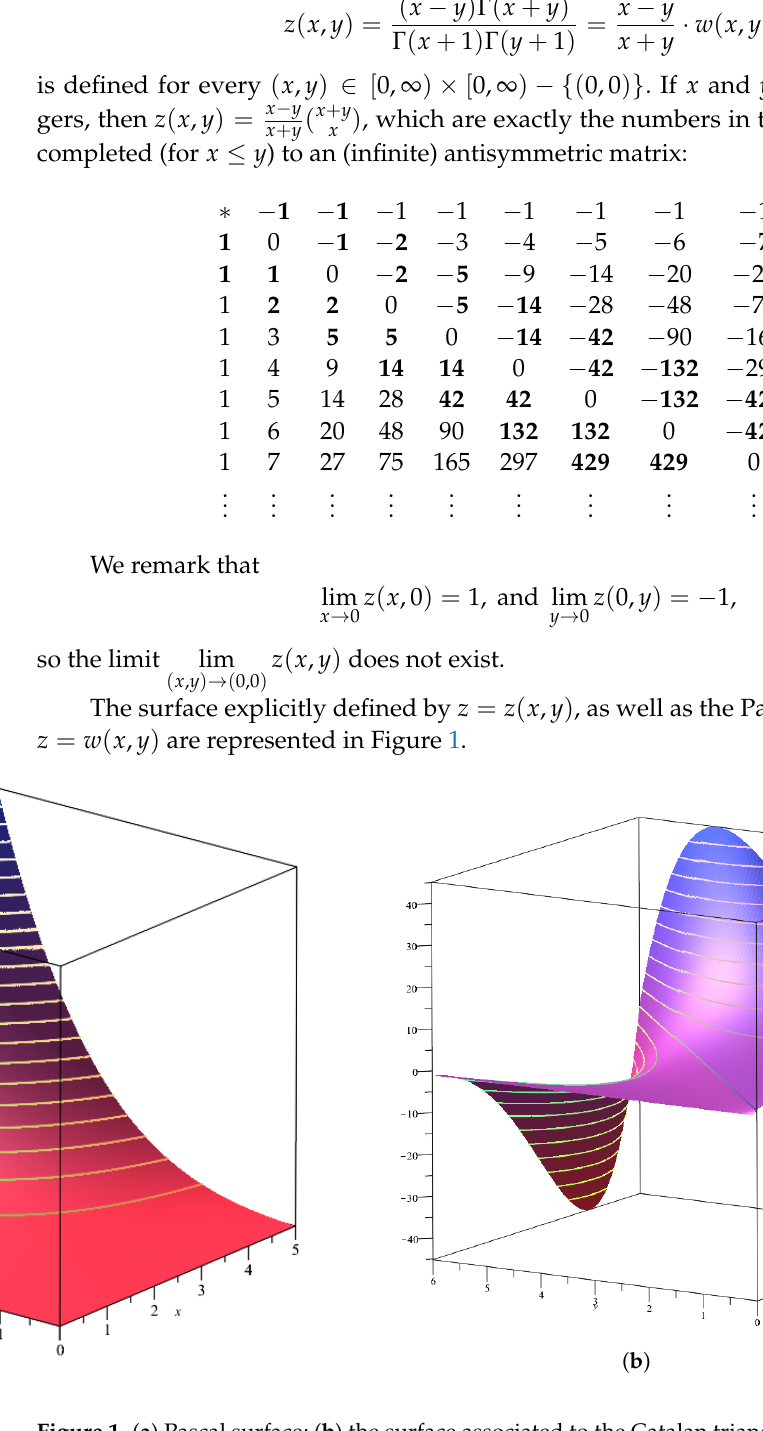
Figure 1. ( a ) Pascal surface; ( b ) the surface associated to the Catalan triangle